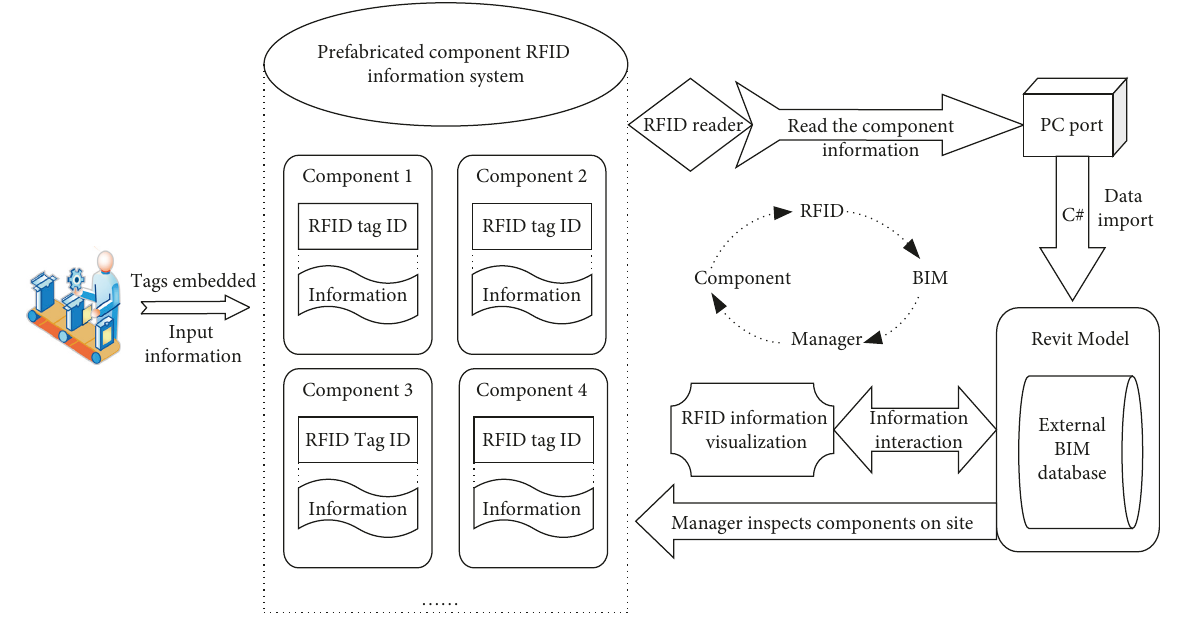
Figure 6: BIM and RFID-based prefabricated component information viewing path.